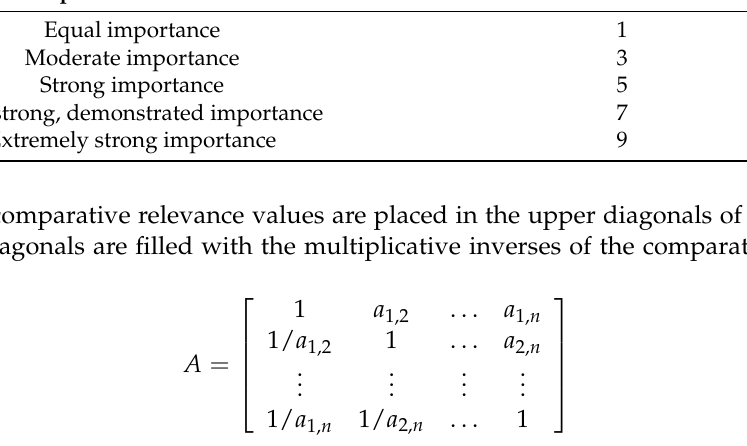
Table 3. Comparative relevance scale [43]. Comparative Relevance Value Equal importance